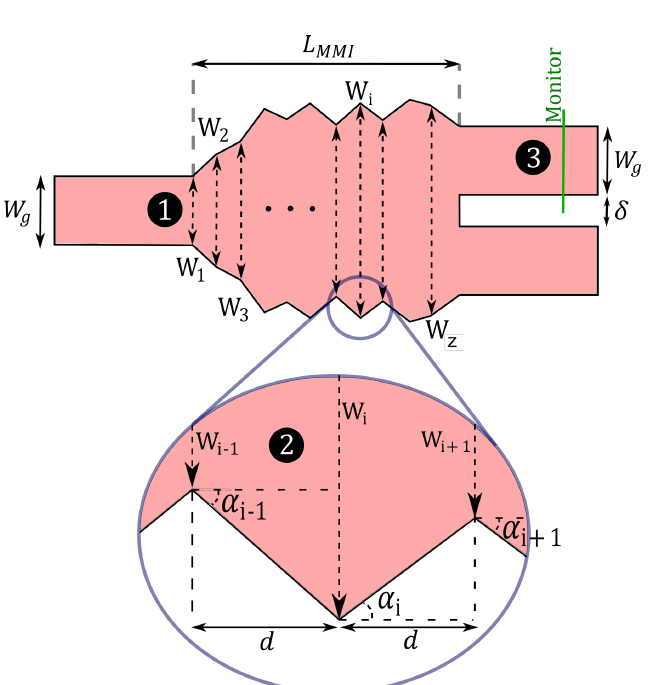
Figure 2. Layout of the top view of the splitter. The lengths of the widths W 1,2,3,..., z were optimized by the angles, α i , which are the parameters of the optimization. The figure of merit (FOM) is the transmittance over a window of frequency taken at the monitor